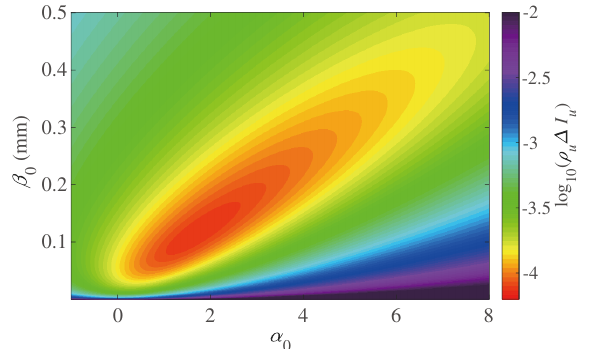
FIG. 7. The contribution coefficient Δ I u to longitudinal emit- tance of an undulator or wiggler vs N u (left) and K (right). To make it dimensionless, the peak curvature radius of the undulator ρ u is multiplied. The blue solid line is the result at is multiplied. Kk u ð α ; β Þ ¼ ð 1 . 64 ; 112 μ m Þ . For each N K , there exists an 0 0 u and optimized α 0 and β 0 , red dashed line gives the optimized result. Here, λ U ¼ 5 cm, K ¼ 6 . 857